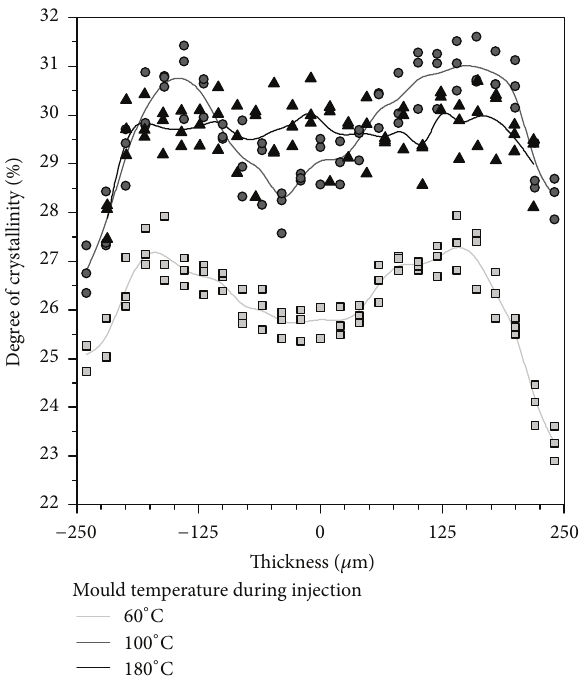
Figure 5: Polymorphy-ratio of the absorbance at a wavelength of 1417 cm −1 ( 𝛼 modification) and 1438 cm −1 ( 𝛽 modification) over the cross section in dependence of process